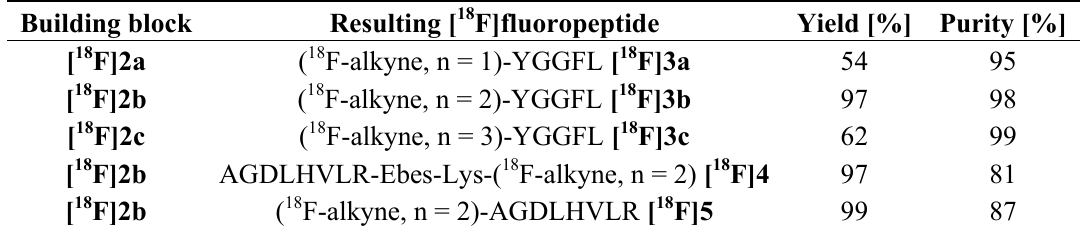
Table 1. Results of the radiolabeling with [ 18 F]2a–c